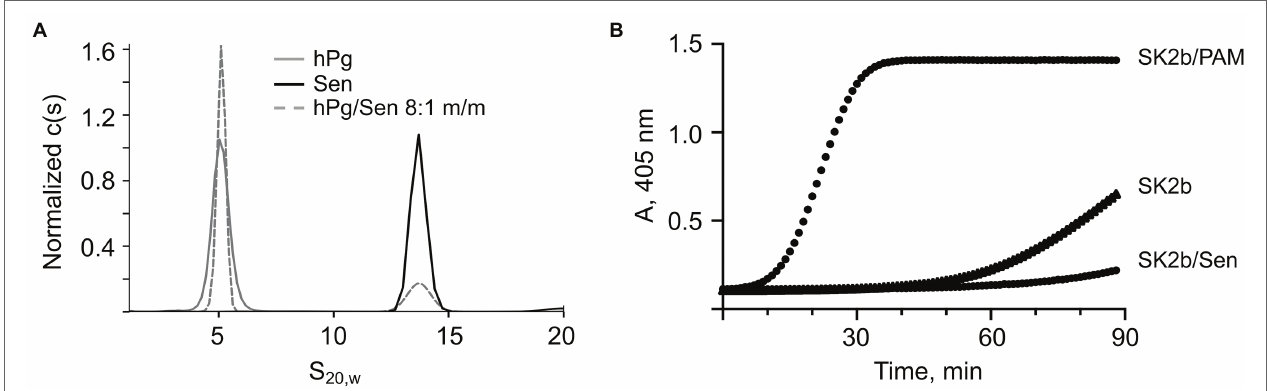
FIGURE 3 | Interaction of hPg with Sen in solution. (A) Sedimentation velocity analysis of the binding of hPg to Sen. An 8:1 m/m mixture of hPg (0.8 μ M) and Sen (0.1 μ M) were mixed and subjected to sedimentation velocity analysis. The two peaks (dashed lines) obtained, shown as overlay of individual sedimentation coefficient profiles of hPg and Sen (solid lines), corresponded to free hPg and free Sen (solid lines) verifying their lack of interaction in solution. Sedimentation velocity experiments were performed at 35,000 rpm at 20 ° C, in 50 mM Na 2 HPO 4 /100 mM NaCl, pH 7.4. The peaks were overlaid using GUSSI https://www.utsouthwestern. edu/labs/mbr/software/. (B) Activation of hPg by SK2b in solution. A mixture of hPg (200 nM) and Sen (0 or 8 μ M) or PAM (0.25 μ M) were added to the wells of non- protein binding microtiter plates and incubated for 10 min at 25 ° C. The chromogenic substrate, S2251 (0.25 mM), was added and the activation was accelerated by addition of SK2b (5 nM). The release of p-nitroaniline from S2251 was continuously monitored for 90 min at A 405nm